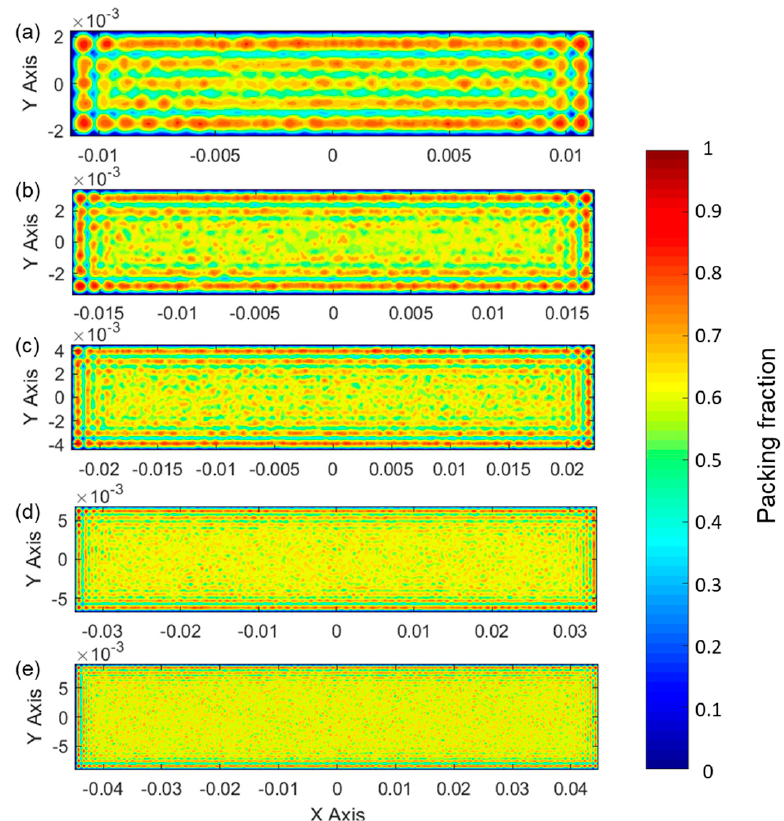
Figure 11. Local packing fraction distribution in the x - y planes of the rectangular pebble beds with a fixed aspect ratio of 5 and various cross-sectional areas of ( a ) 100 d 2 , ( b ) 225 d 2 , ( c ) 400 d 2 , ( d ) 900 d 2 , ( e ) 1600 d 2 (Color online).